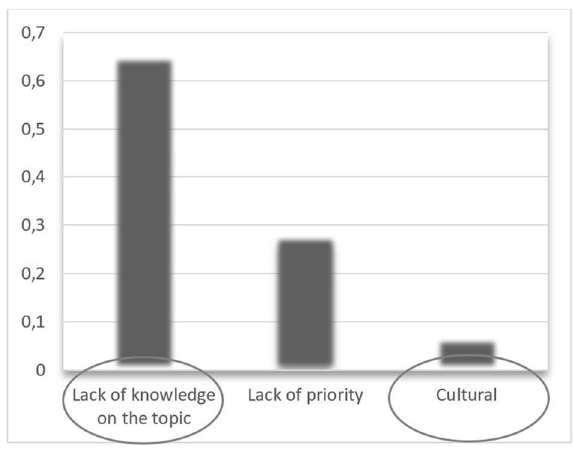
Fig. 1 Relative priorities: internal factors (Source: David et al.